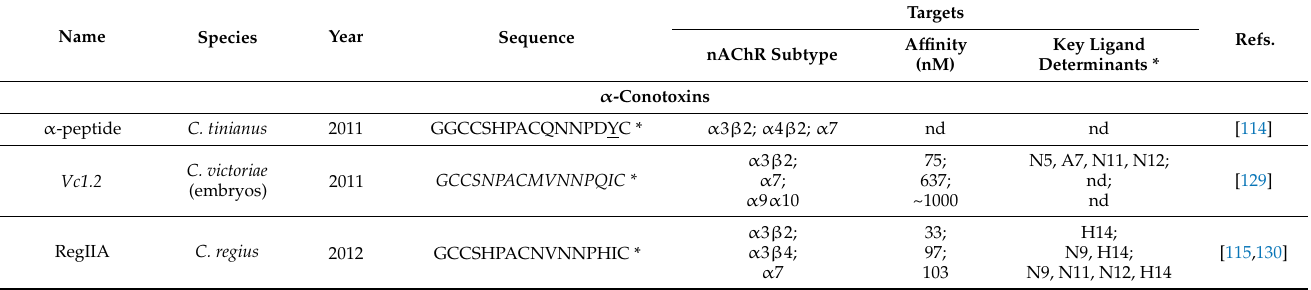
Table 2. New conotoxins published last decade. The italicized names and sequences mean that these peptides were identified by cDNA libraries. The asterisk means the amidated